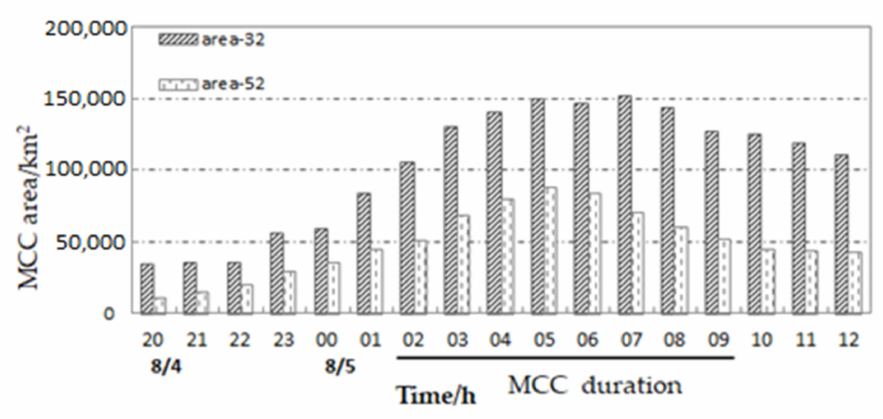
Figure 4. Hour-by-hour changes of the − 32 ◦ C and − 52 ◦ C areas of convective cloud cluster from 20:00 BT 4 to 12: 00 BT on 5 August